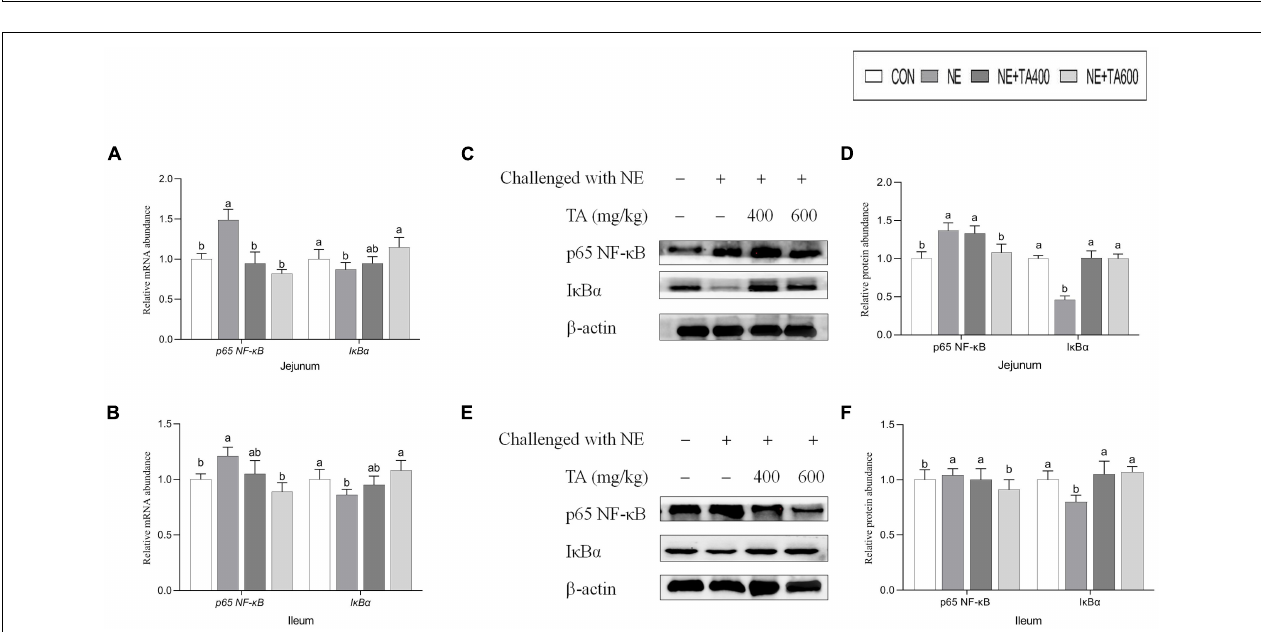
FIGURE 5 | The effects of TA on mRNA abundance of jejunal and ileal inflammatory cytokines of subclinical NE broilers. Values were expressed as mean with standard error represented by vertical bars. a − c Means with different letters differ significantly among the groups ( P < 0.05). IL-1 β , interleukin-1 β ; IL-2 , interleukin-2; IL-4 , interleukin-4; IL-8 , interleukin-8; IL-10 , interleukin-10; TNF- α , tumor necrosis factor- α ; IFN- γ , interferon- γ ; iNOS , inducible nitric oxide synthase.